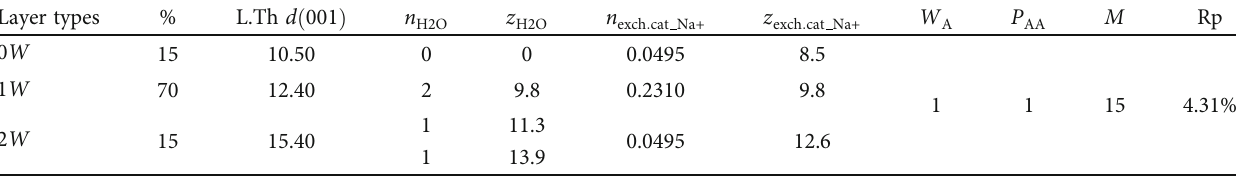
Table 4: Optimal structural parameters obtained from quantitative XRD analysis in the case of the SWy-Na sample. Layer